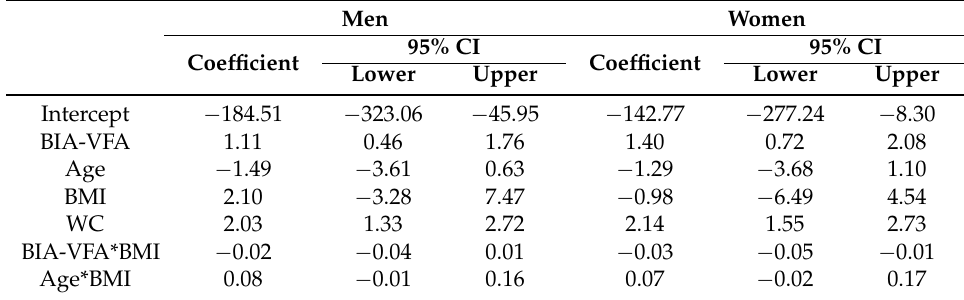
Table 5. Multivariate regression models for prediction of VFA measured by CT according to gender.